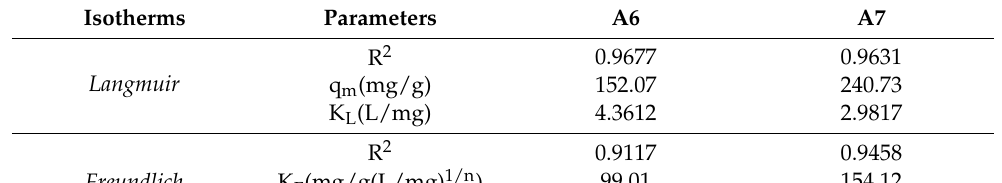
Table 6. Parameters of non-linear form Langmuir’s and Freundlich’s equations. Isotherms